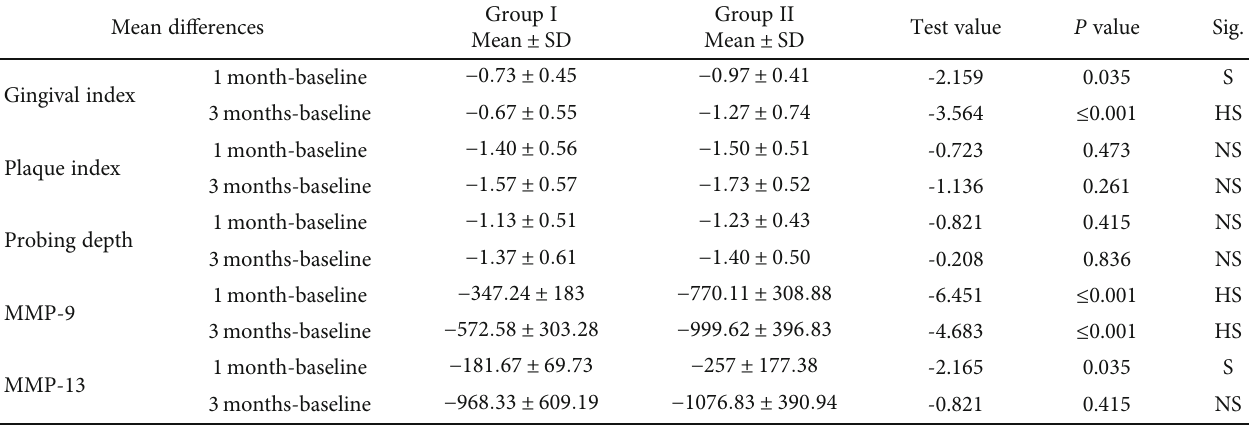
Table 1: The reduction in di ff erent clinical and biochemical parameters in both groups.